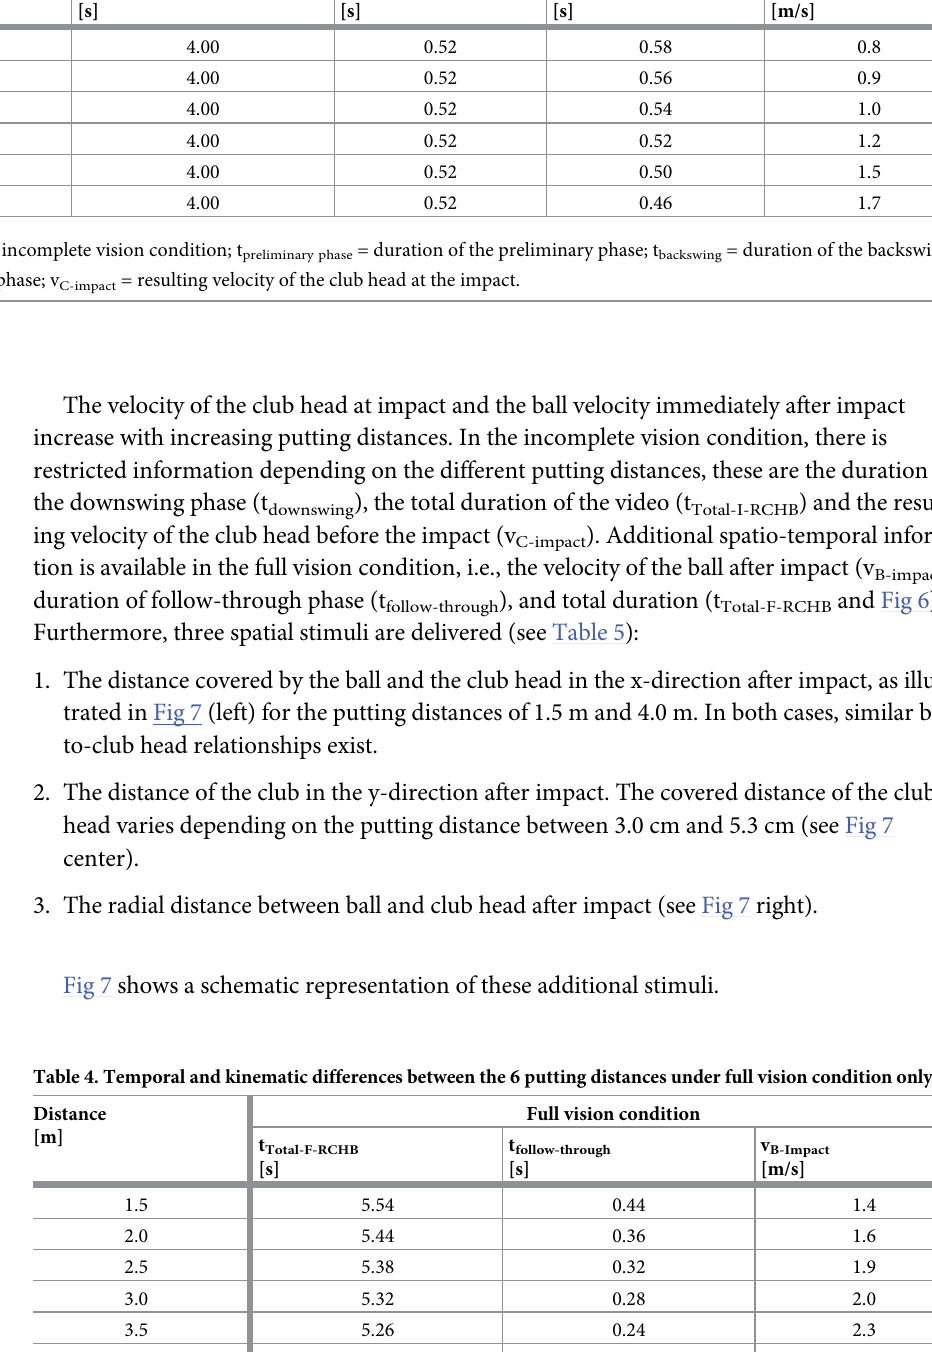
t Total-F-RCHB = total duration of the video in the full vision condition; t follow-through = duration of follow-through phase; v B-Impact = resulting velocity of the ball after the